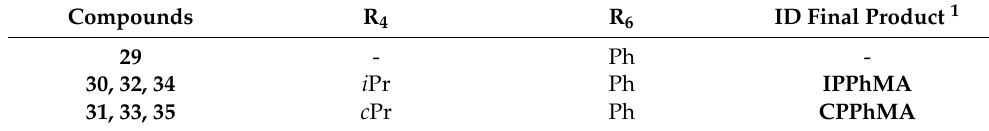
Table 3. R substituents for the three series of TMA analogs.